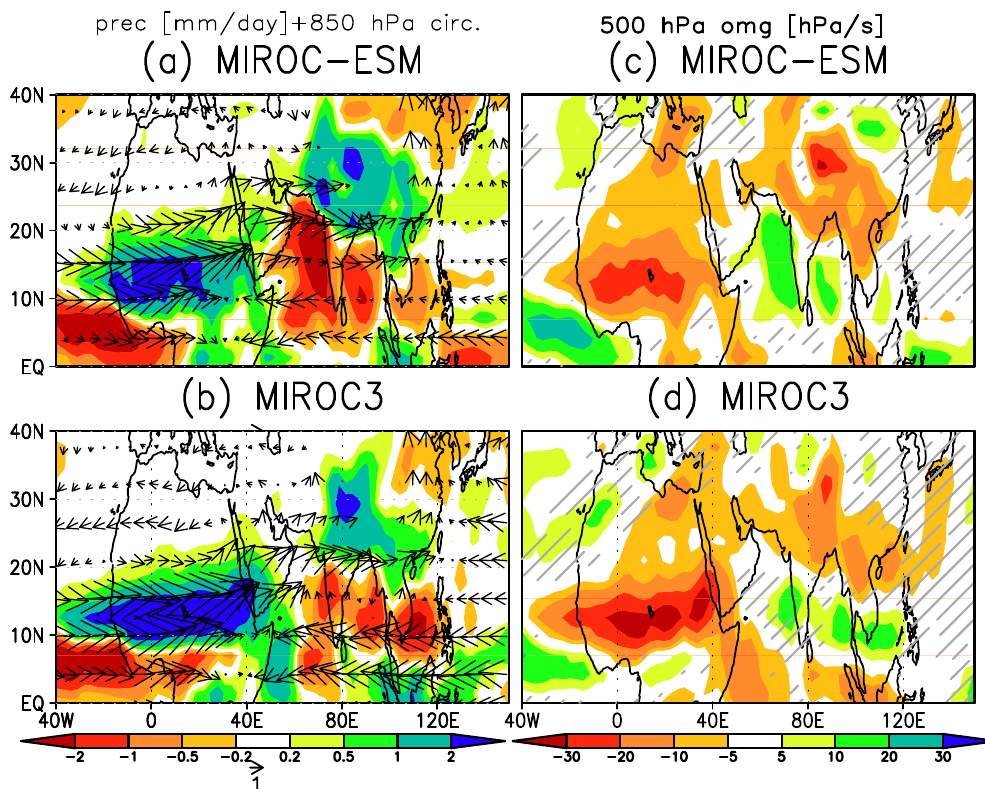
Fig. 12. Left panels: 6–0ka precipitation changes (colored shading) and wind changes at 850hPa (arrows) in JJAS obtained with (a) MIROC- ESM and (b) MIROC3. Right panels: 6–0ka change in vertical motion at 500hPa (colored shading) (hPas − 1 ) in JJAS obtained with (c) MIROC-ESM and (d) MIROC3. Areas where the change is insignificant based on a t test (95%) are shown